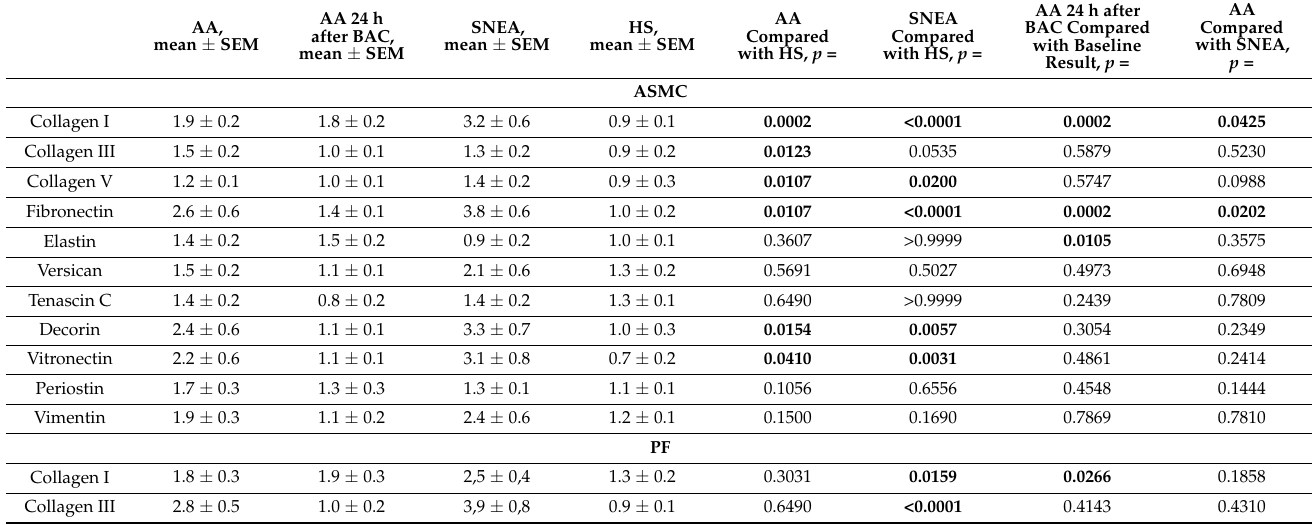
Table A3. The results of ECM gene expression analysis and significant changes in gene expression